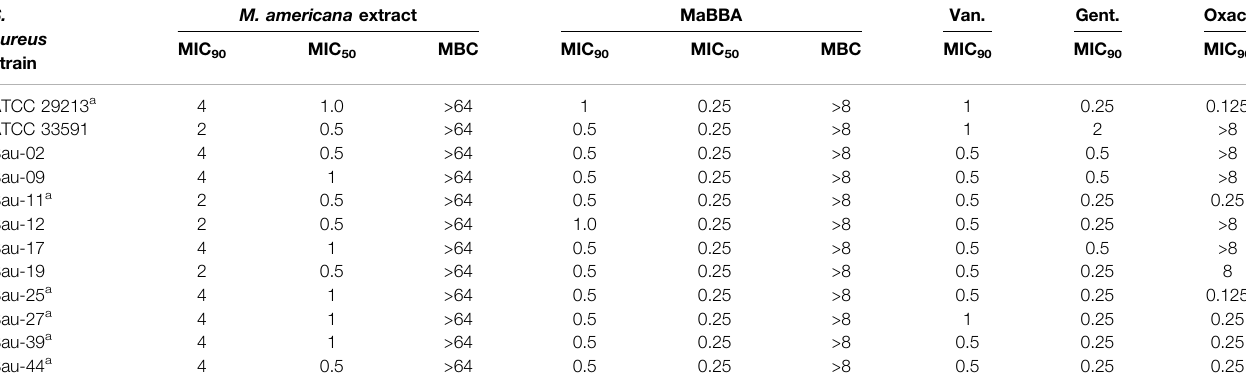
TABLE 2 | Minimum inhibitory concentration (µg/ml) and minimum bactericidal concentration (µg/ml) of the extract of M. americana and MaBBA in different strains of clinical isolates of S. aureus . S. M. americana extract aureus strain